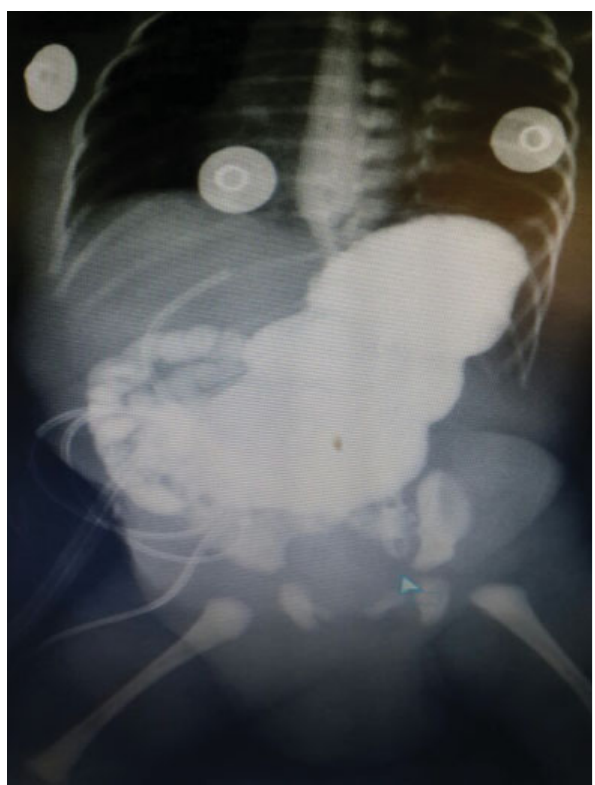
Fig. 4 Postoperative contrast study with the dye passing into the small